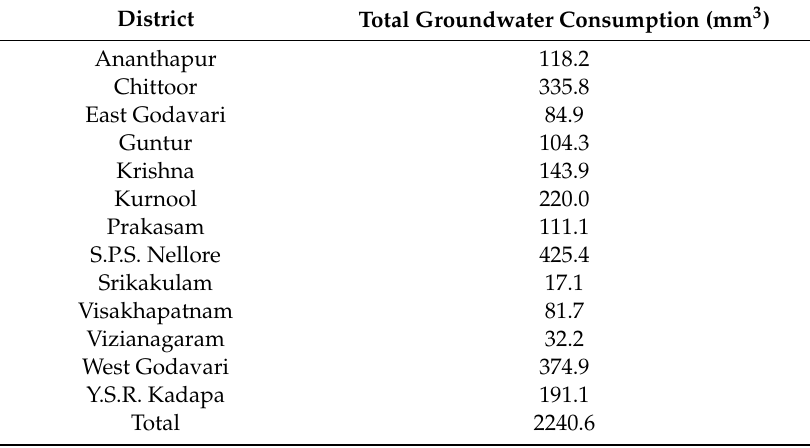
Table 4. Total groundwater consumption across the study area.